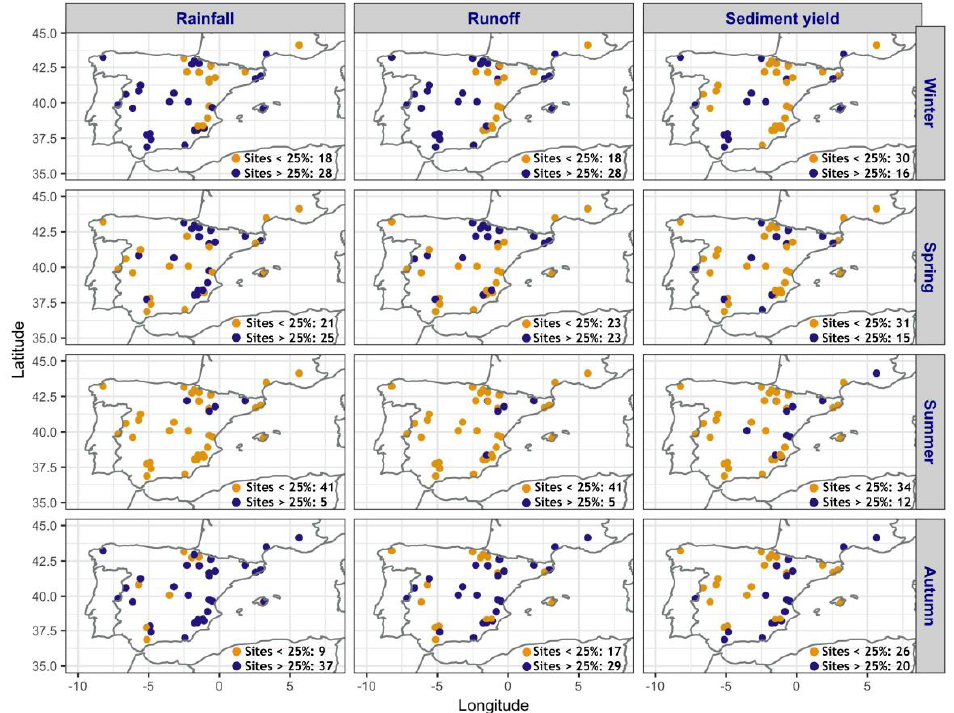
Figure 2. Spatial distribution of the percentage of rainfall, runoff, and sediment yield for each season in the study sites, and the number of sites with values higher or lower than 25%. The seasonal percentage contribution of rainfall, runoff and SY by different WTs are shown in Figure 3. The WTs with more generalized high percentage contribution are C (cyclonic) and W (west) types. The C type contributes to the three variables in all the seasons, reaching the lowest contributions in summer SY. The westerly types (W, NW, and SW) present a high contribution in rainfall and runoff for winter, spring, and autumn, and to a lesser extent in summer SY. The easterly types (E, NE, and SE) have a high contribution in summer rainfall and runoff, and also, in relative terms, in summer SY. North WT shows a high contribution for rainfall in spring and autumn, and for runoff and SY in spring. South WT contribution is mainly concentrated in spring in rainfall, runoff, and SY.